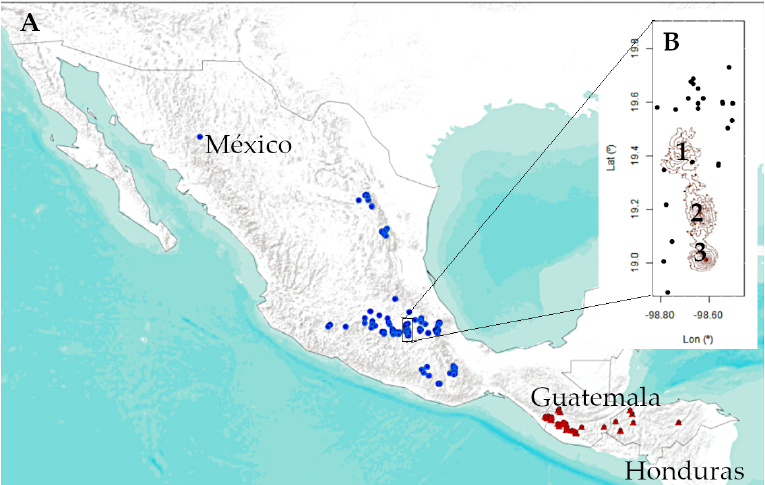
Figure 1. P. hartwegii occurrence data. ( A ): Mexican National Forest Inventory (Green dots); World’s Conifer Atlas [47] (Yellow dots). ( B ): Available meteorological stations [51] (Black dots) on the topographic map of Izta Popo National Park (lines ranging from 3600 to 5400 m a.s.l. every 200 m). 1: Tláloc (4120 m a.s.l.); 2: Iztaccíhuatl (5230 m a.s.l.); 3: Popocatépetl (5452 m a.s.l.). Ranging from 3600 to 5480 m a.s.l., and covering an area of 39,819.09 ha, the Izta- Popo National Park hosts two of the three highest volcanoes in Mexico (Figure 1). This